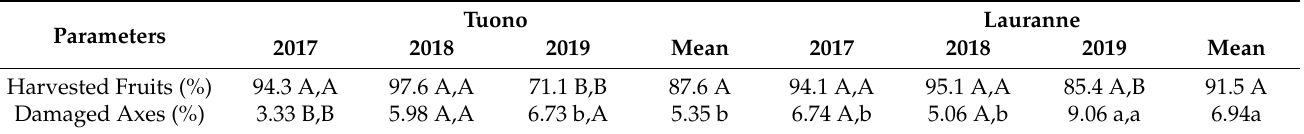
Table 2. Harvested fruits and damaged axes of cultivars Tuono and Lauranne in three subsequent years (2017–2019). The first letters denote statistical differences between cultivars for each year; the second letters denote statistical differences among years for each cultivar ( p = 0.05/0.01; SNK